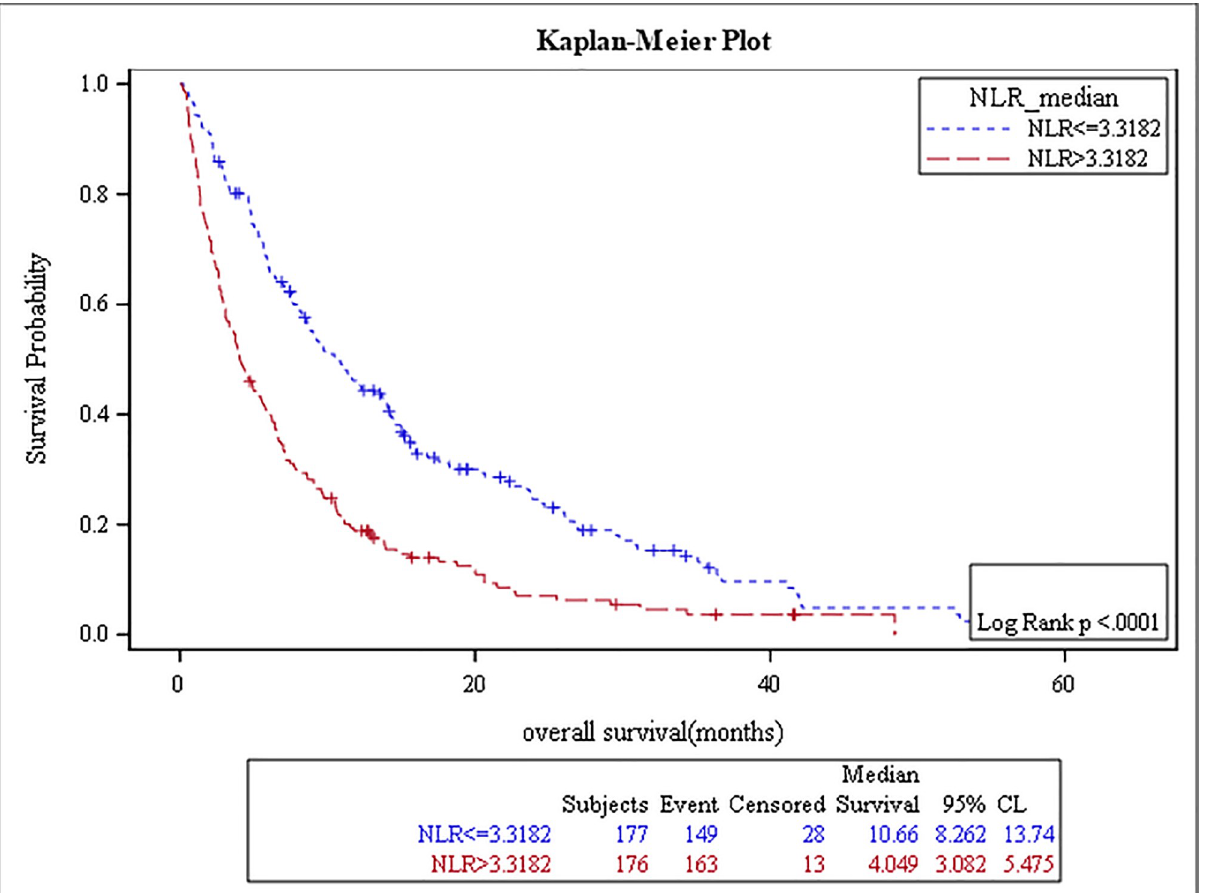
Fig 3. Kaplan Meier curve for overall survival for patients with NLR �